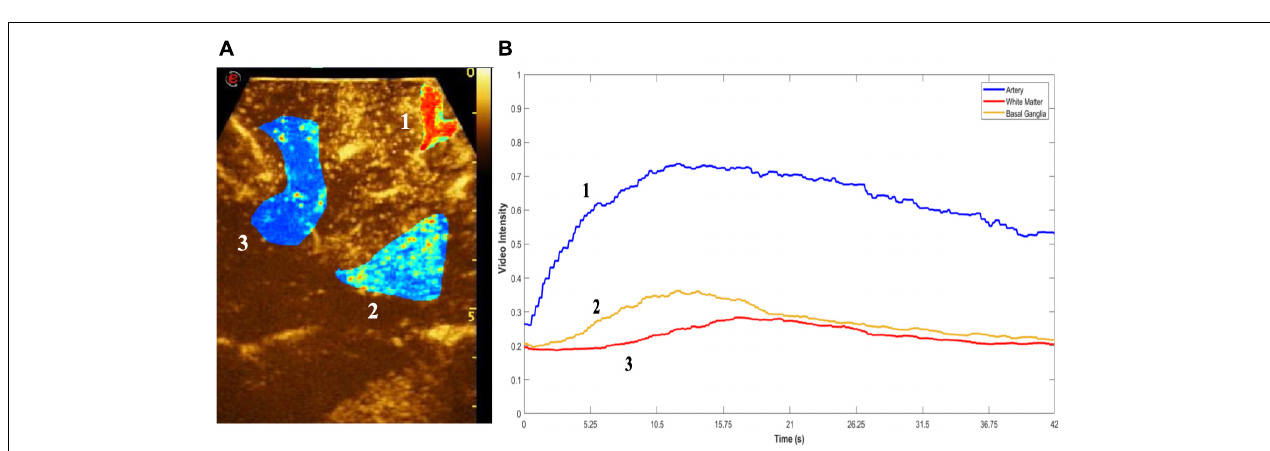
FIGURE 1 | Doppler techniques (Color-Doppler, X-Flow, Micro-V). Color Doppler and spectral Doppler (A) bring information about flow direction and velocity with quantification of the velocity through spectral Doppler. X-Flow (B) maximizes spatial resolution and Doppler signal penetration capabilities. Micro-V (C) permits real-time micro-vascular perfusion analysis, identifying low flow signals.